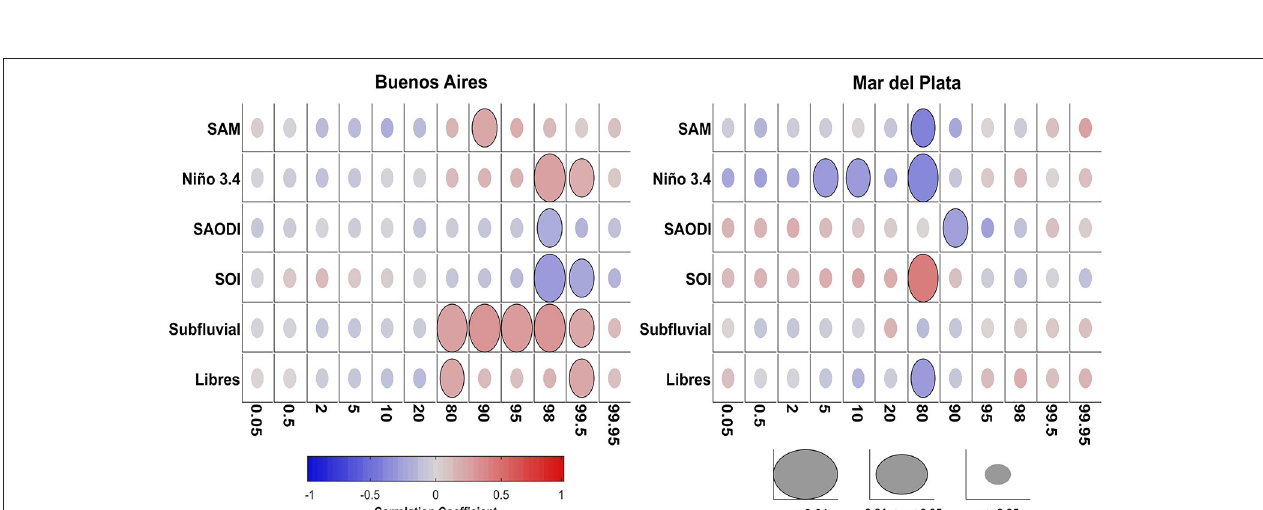
Frontiers in Marine Science | www.frontiersin.org